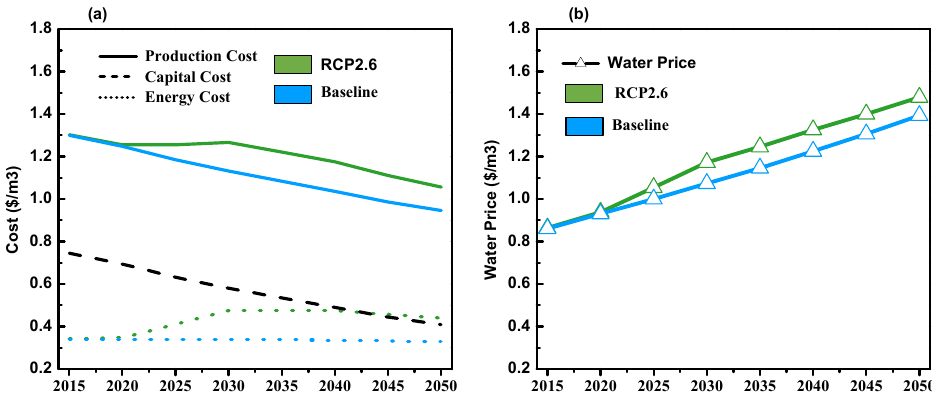
Figure 3. Averaged future projections of unit production costs ( C p ), capital costs ( C u ), and energy costs ( E T ) for reverse osmosis technology (SWRO) ( a ) and water price ( b ) in 140 countries under baseline and RCP2.6 scenarios. Blue, and green, lines indicate baseline and RCP2.6, respectively. Solid, dashed lines, dotted lines, and triangles with solid lines indicate unit production cost, capital cost, energy cost, and water price, respectively.